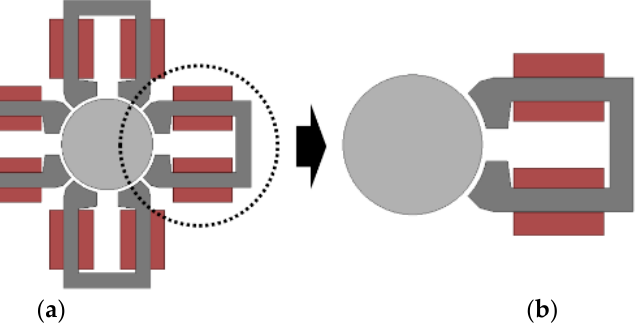
Figure 7. Conventional magnetic bearings and STBM magnetic flux line: ( a ) conventional magnetic flux line and ( b ) STMB magnetic flux line.